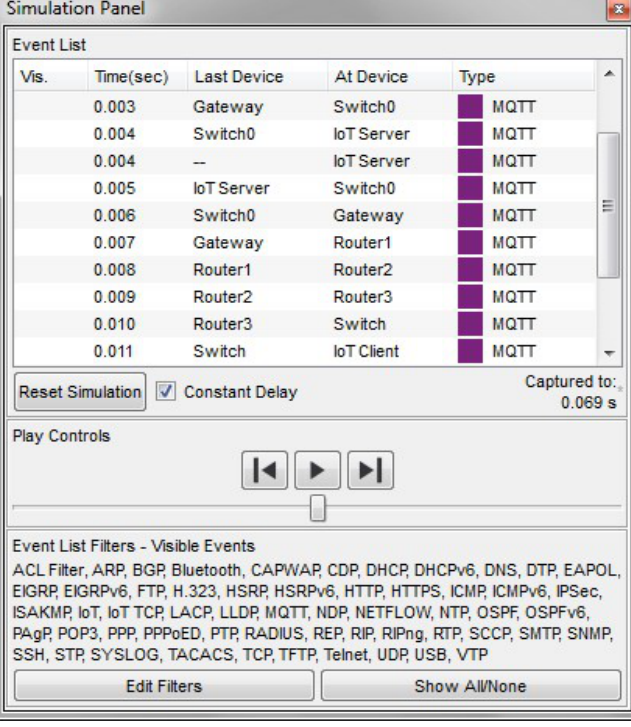
Figure 15. Packet capture for IoT communication with